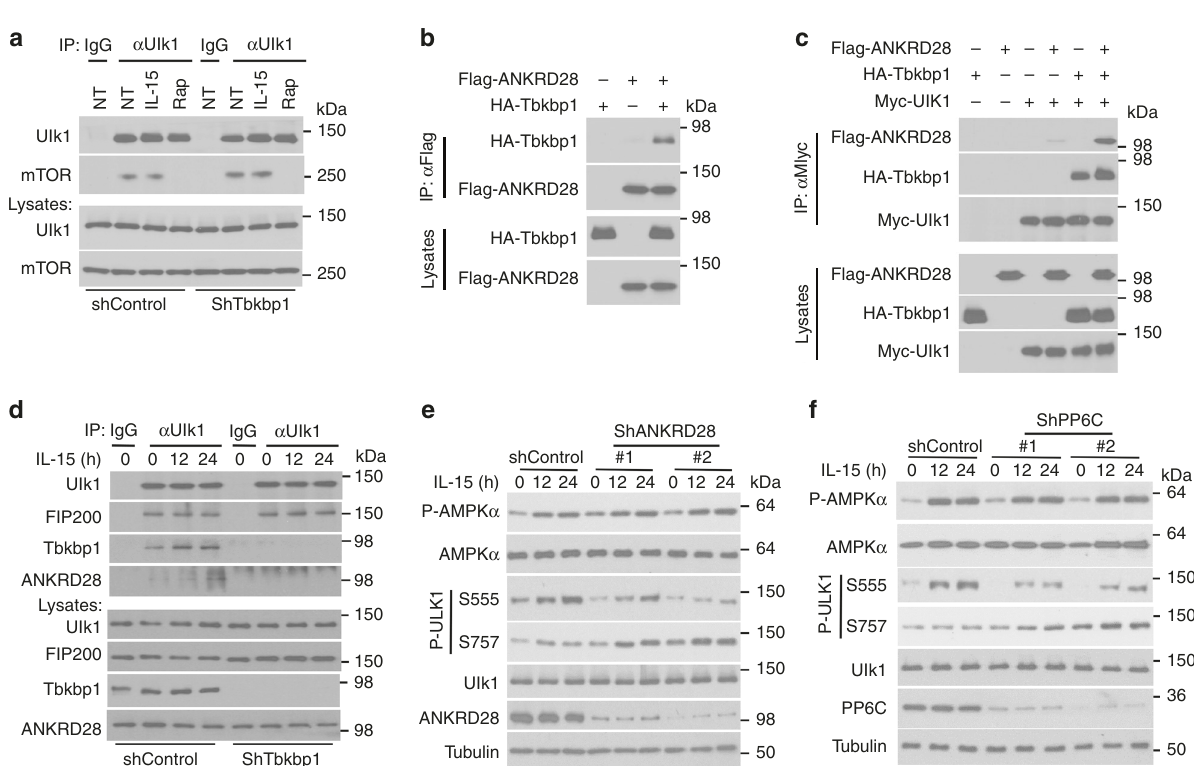
(Fig. 6h). Consistent with the FIP200-Ulk1 association, Tbkbp1 also interacted with Ulk1 in transfected cells and was co- precipitated with both FIP200 and Ulk1 under endogenous conditions (Fig. 6i, j). Tbkbp1 contains several domains, includ- ing a TBK-binding domain (TBD) (Fig. 6k) that is also present in several other TBK1-binding proteins 2 . Interestingly, the TBD,